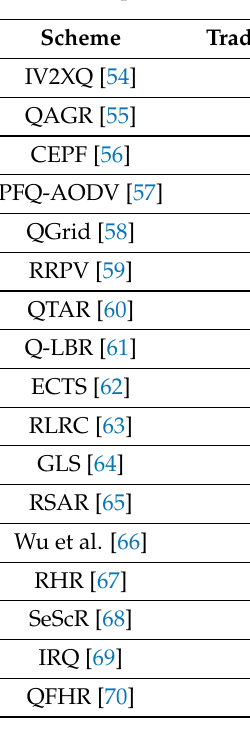
Table 15. Comparison of RL-based routing schemes according to learning process.